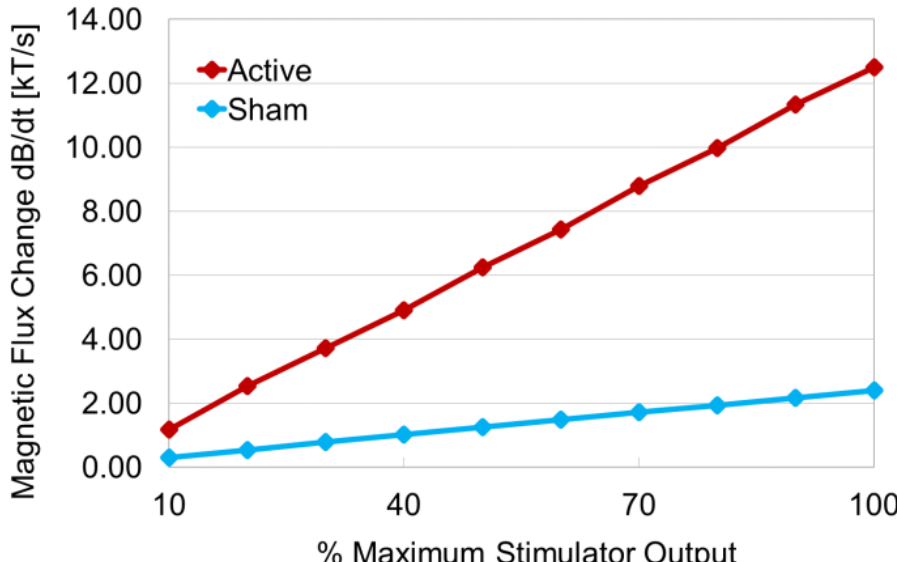
Figure 5. Relationship between magnetic flux and MSO strength. The horizontal axis shows the machine stimulator output (MSO) and the vertical axis indicates the magnetic flux change. MSO, which indicates the stimulus intensity of the TMS device, was increased from 10% to 100% in 10% intervals, and the magnetic flux change corresponding to each MSO for each coil was measured. The red line represents the measurement results of the active coil and the blue line shows the measurement results of the sham coil. In both coils, the magnetic flux change increased linearly with increasing stimulus intensity.